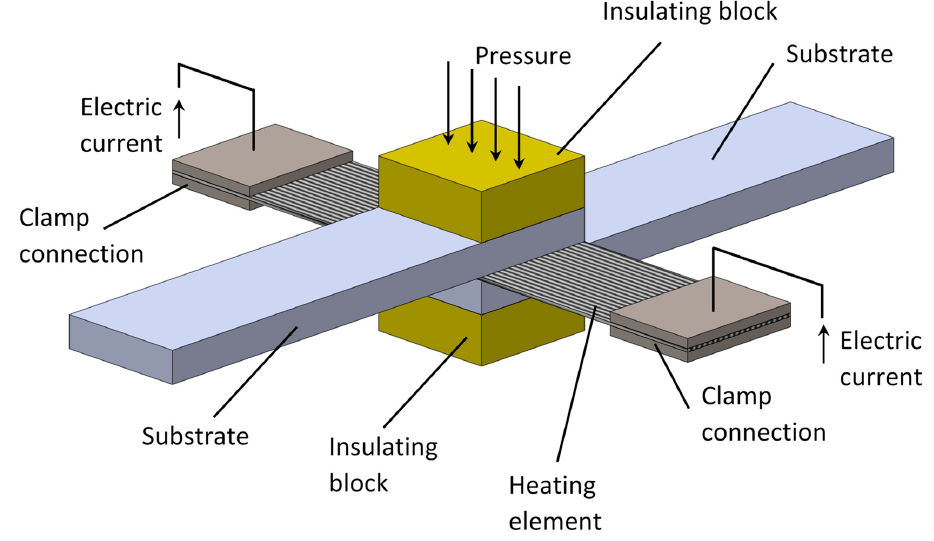
Figure 11. Schematic representation of resistance welding process.